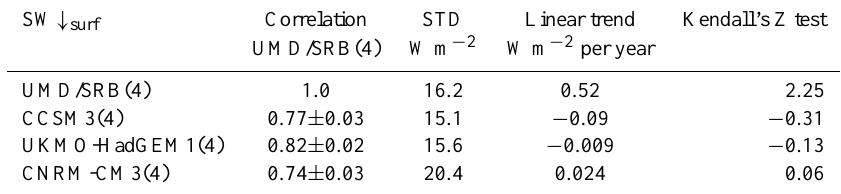
Table 3. Correlation coefficients, and their error interval, between shortwave SW ↓ surf averaged over El Ni˜no 4 region for AMIP II and UMD/SRB models. Standard deviation of SW ↓ surf (STD). Linear trend and significance of the trend (Kendall’s Z